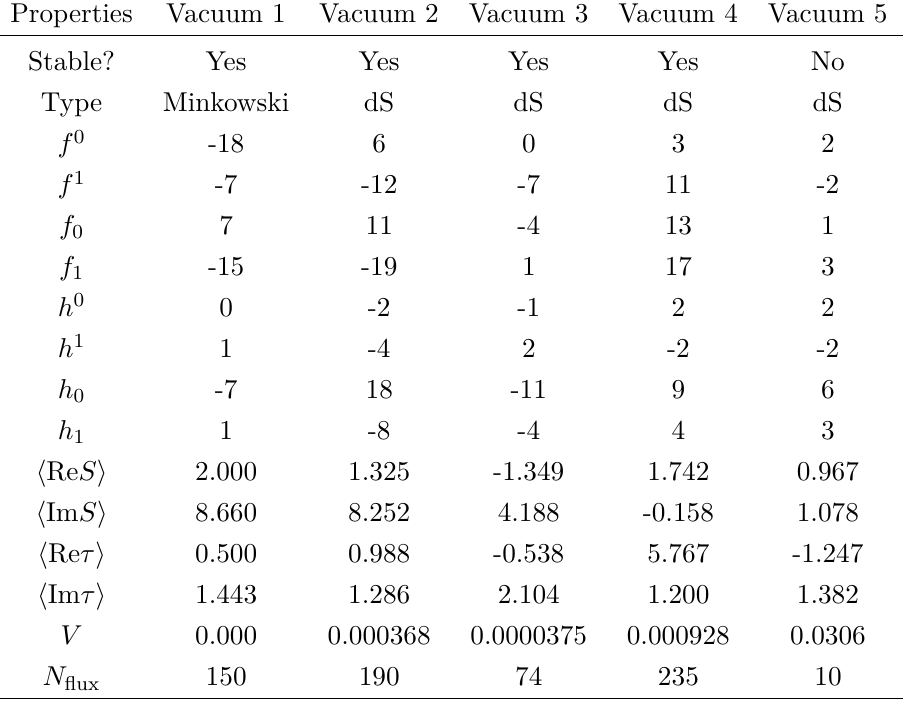
Table 5 . The benchmark points for Minkowski and dS vacua with the isotropic complex structure modulus.